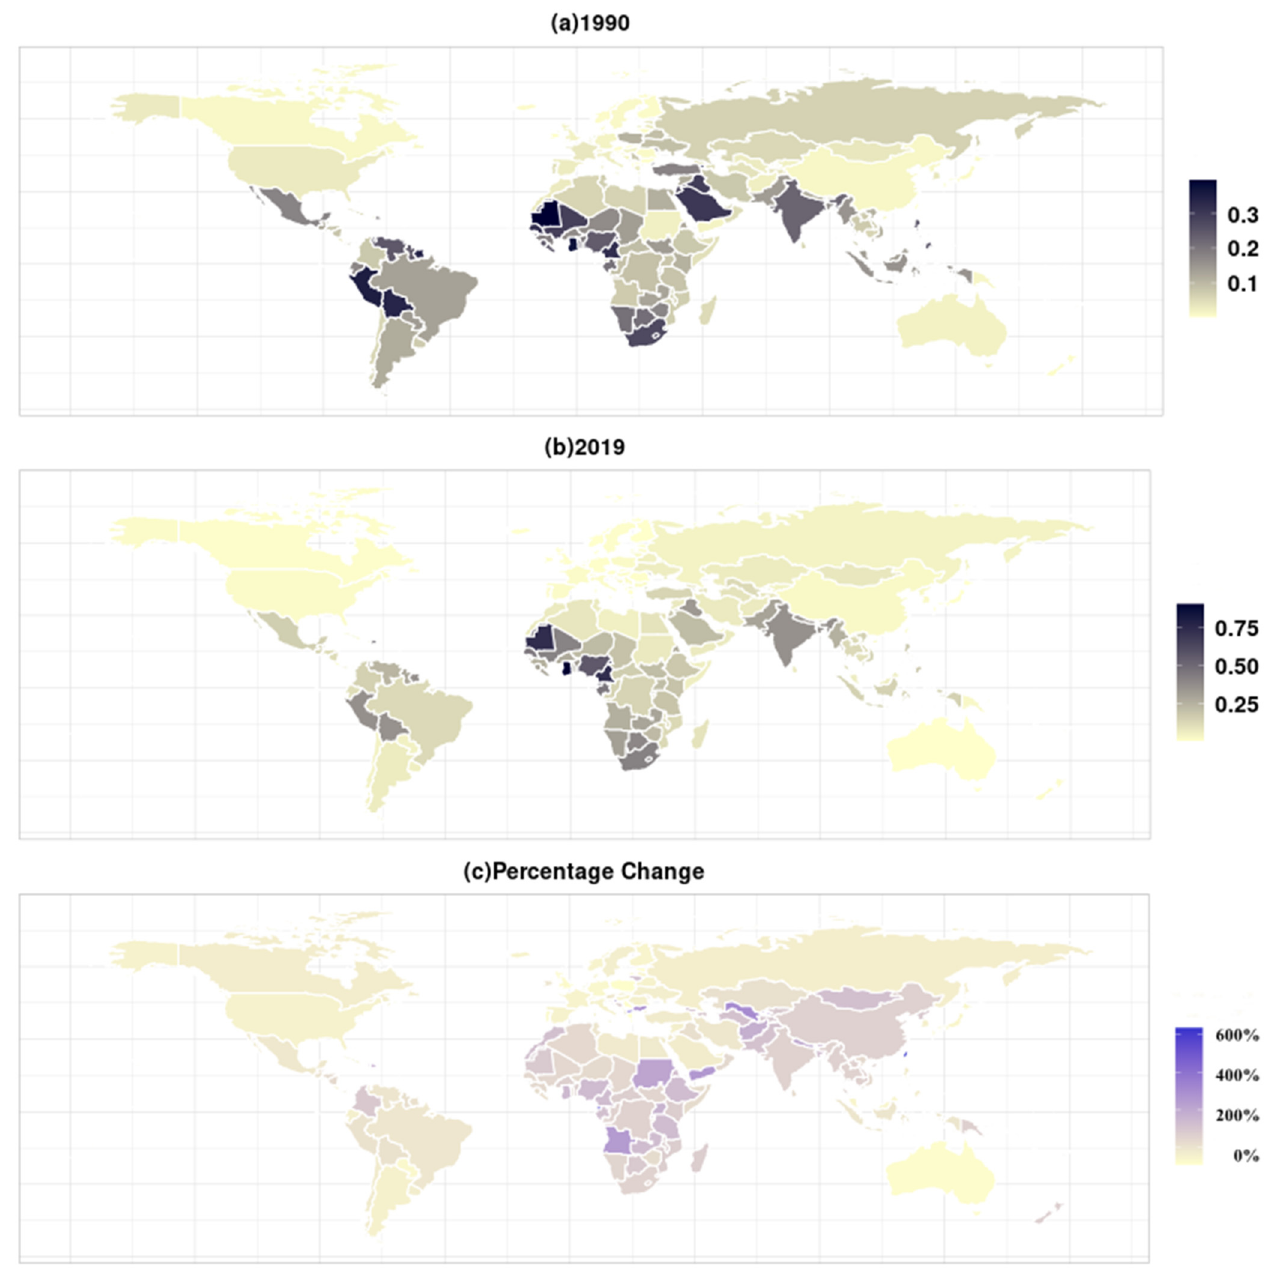
Figure 5. Age-standardized mortality rates (per 100 thousand) for PM2.5-related neonatal infections globally in ( a ) 1990 and ( b ) 2019 and ( c ) percentage changes in 1990–2019.